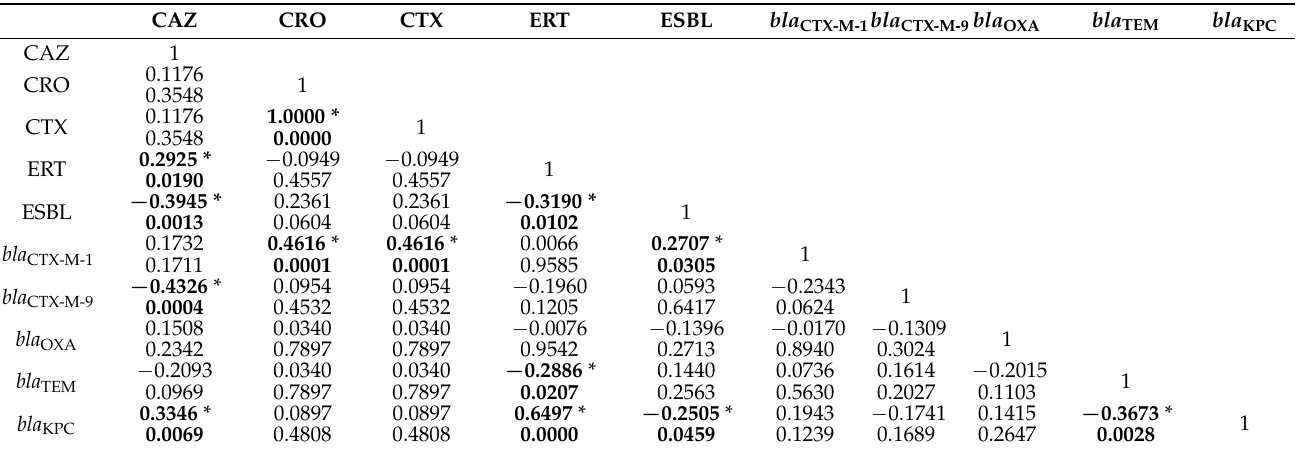
Table 2. Correlation of antibiotic resistance phenotypes and